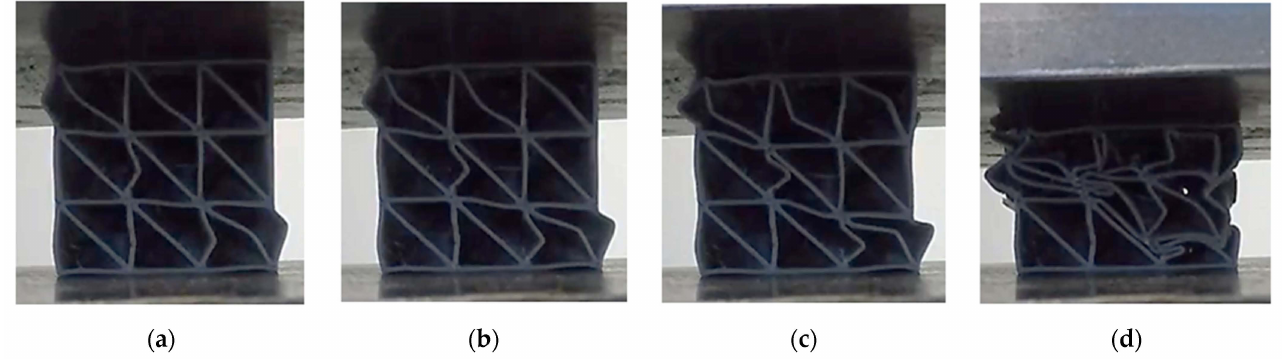
Figure 11. ( a – d ) Experimentally-observed deformation sequence of the 50%-scale novel honeycomb sample under lateral load: plastic buckling first appears on the principal diagonal of the sample that is oriented along the direction of the diagonal walls.